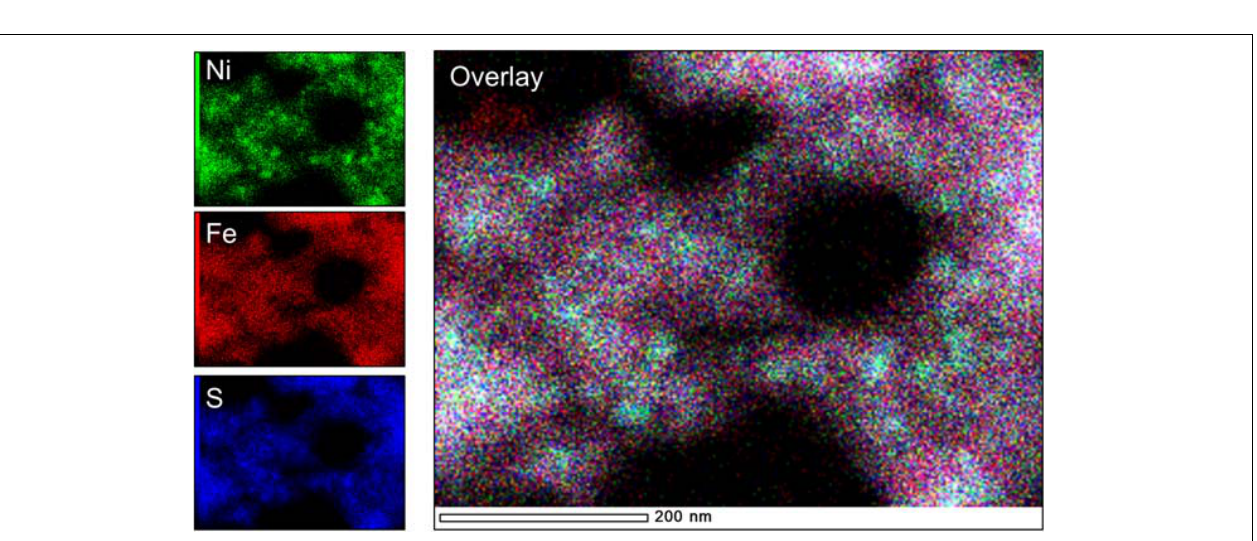
Frontiers in Earth Science |